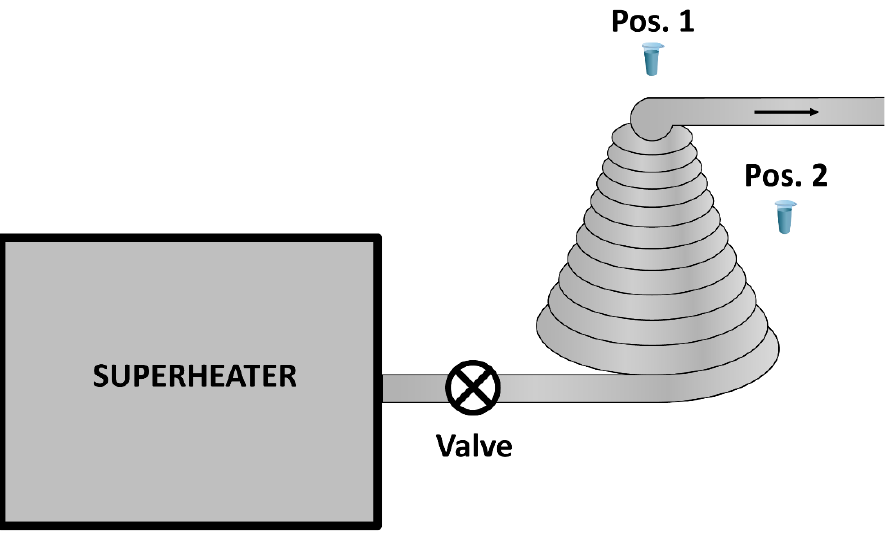
Figure 2. Experimental setup. Arrow indicates the direction of the steam flow. The heat exchanger was covered with a thermal shield.